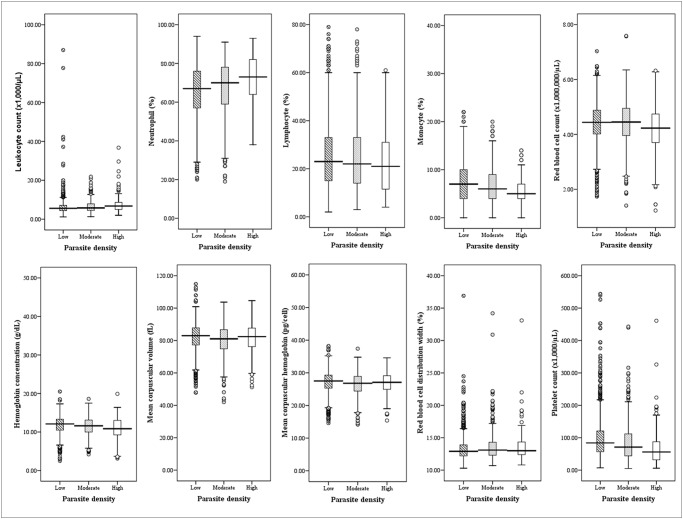
Significant differences in the hematological parameters of various parasite densities of malaria.